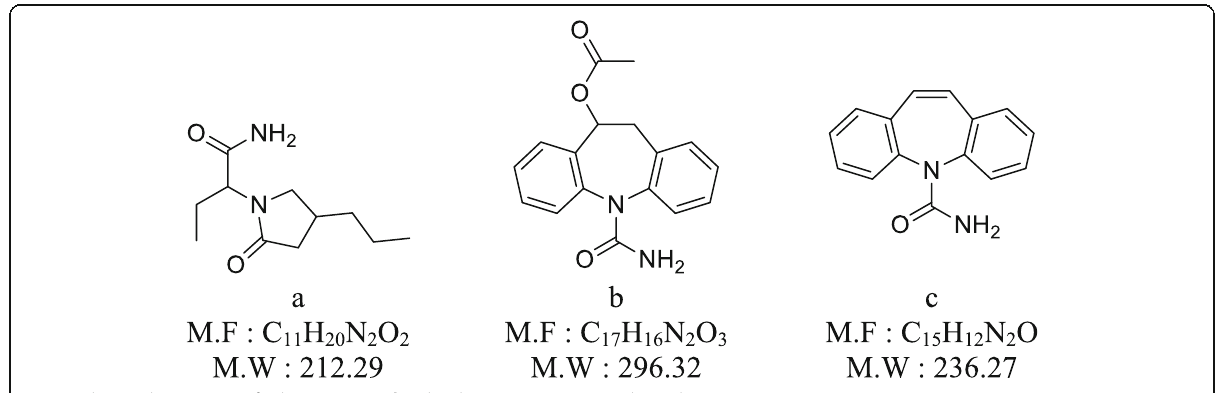
Fig. 1 Chemical structures of a brivaracetam, b eslicarbazepine acetate, and c